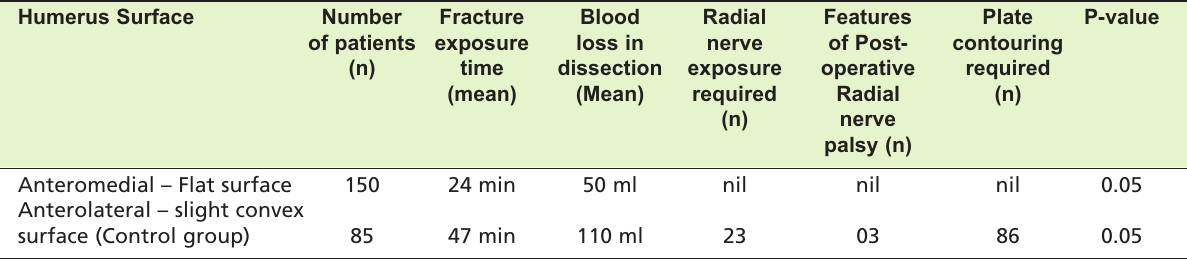
Comparison between application of plate on flat anteromedial surface vs application of plate on Table II: anterolateral surface Humerus